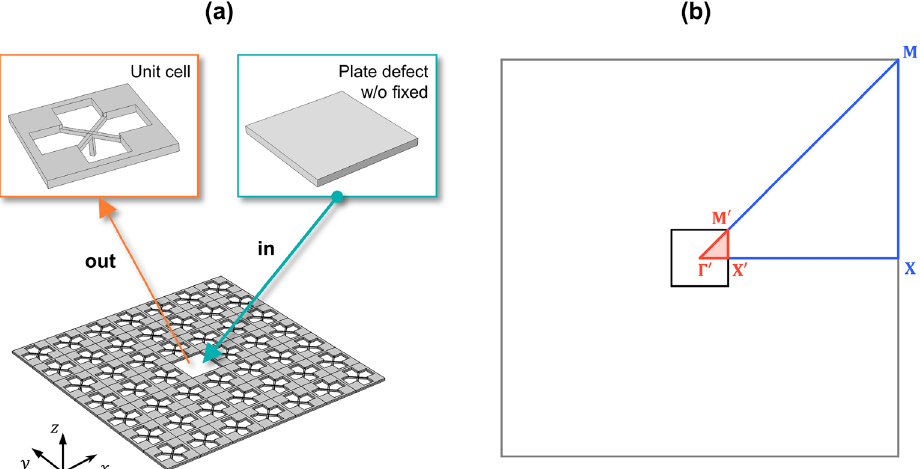
Figure 4. Wave localization using the normal defect. ( a ) Substituting the center unit cell with the plane-type defect. ( b ) The first irreducible Brillouin zone of the